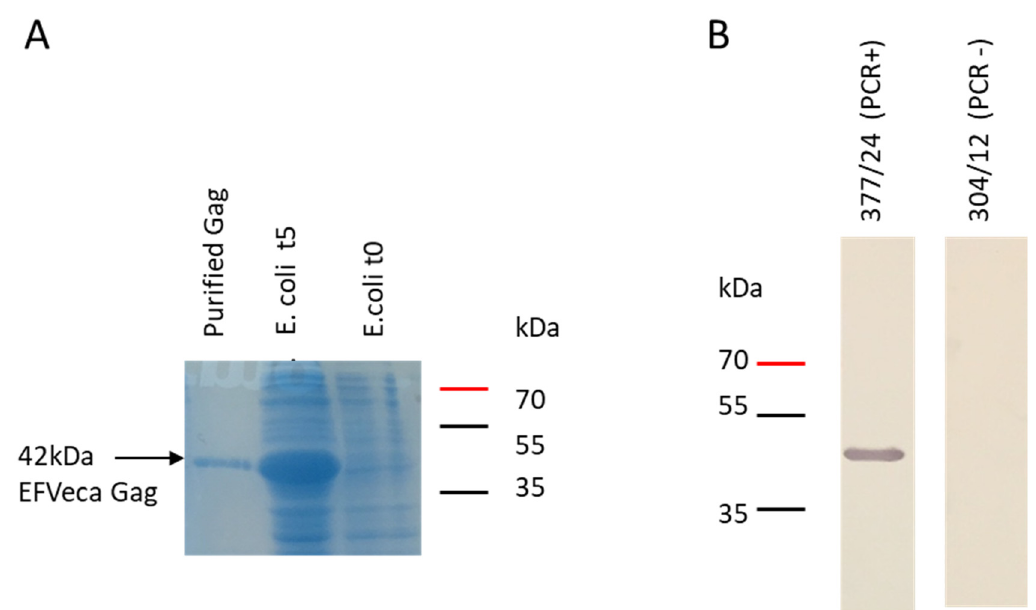
Figure 3. Confirmation of the overexpression of N-terminal/central part of EFVeca Gag protein; ( A ) SDS-PAGE with the E.coli lysate before (t0) and five hours after induction with IPTG (t5) and purified Gag protein; ( B ) detection of EFVeca Gag antigen by immunoblotting with horse serum samples from PCR EFVeca positive and negative individuals. The band of approximately 42 kDa corresponds to the recombinant EFVeca Gag antigen fused with His-tag.